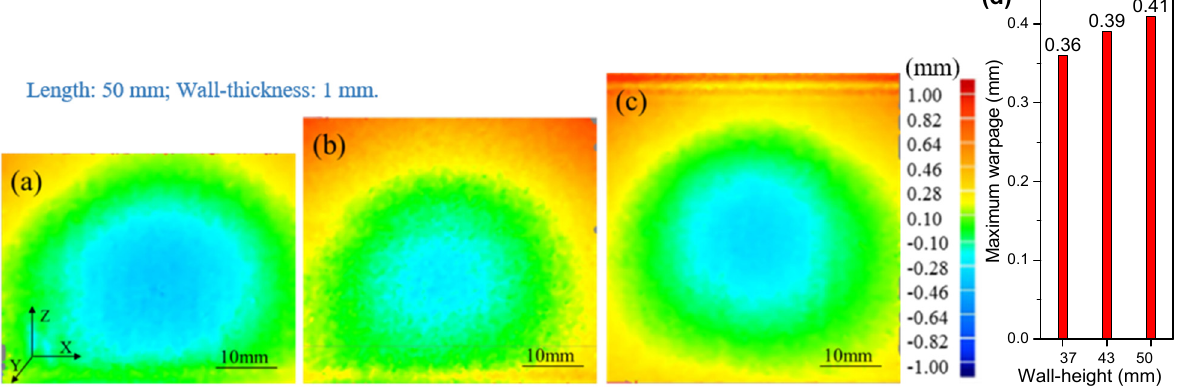
Figure 4. Residual warpage contour-fills of the thin-walled structures with different heights: ( a ) 37 mm; ( b ) 43 mm; ( c ) 50 mm, respectively. ( d ) Maximum warpages recorded in the middle section.